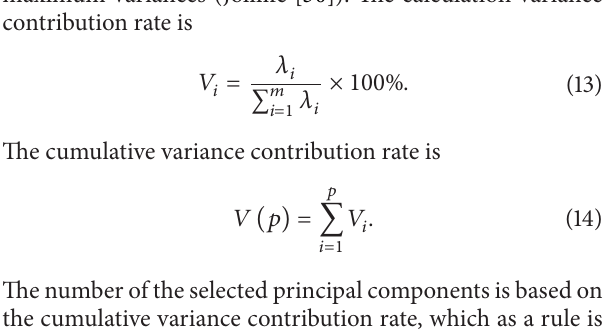
Figure 2: Daily crude oil prices from January 1, 198, to September 30,